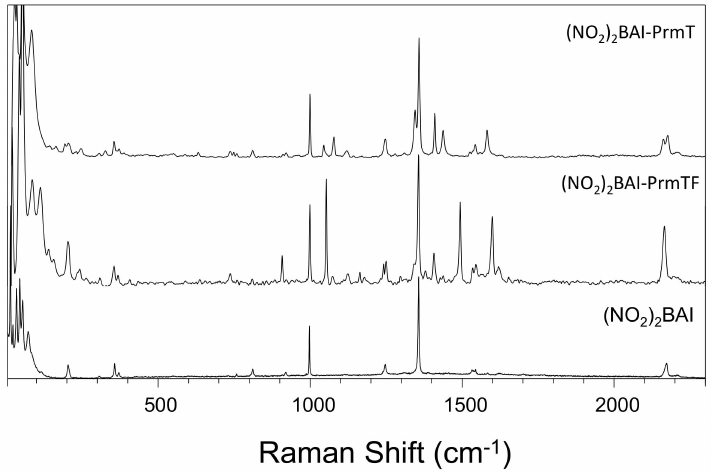
Figure 5. Experimental Raman spectra of (NO 2 ) 2 BAI (bottom), and co-crystals formed from (NO 2 ) 2 BAI with either PrmF (middle) or PrmT (top).